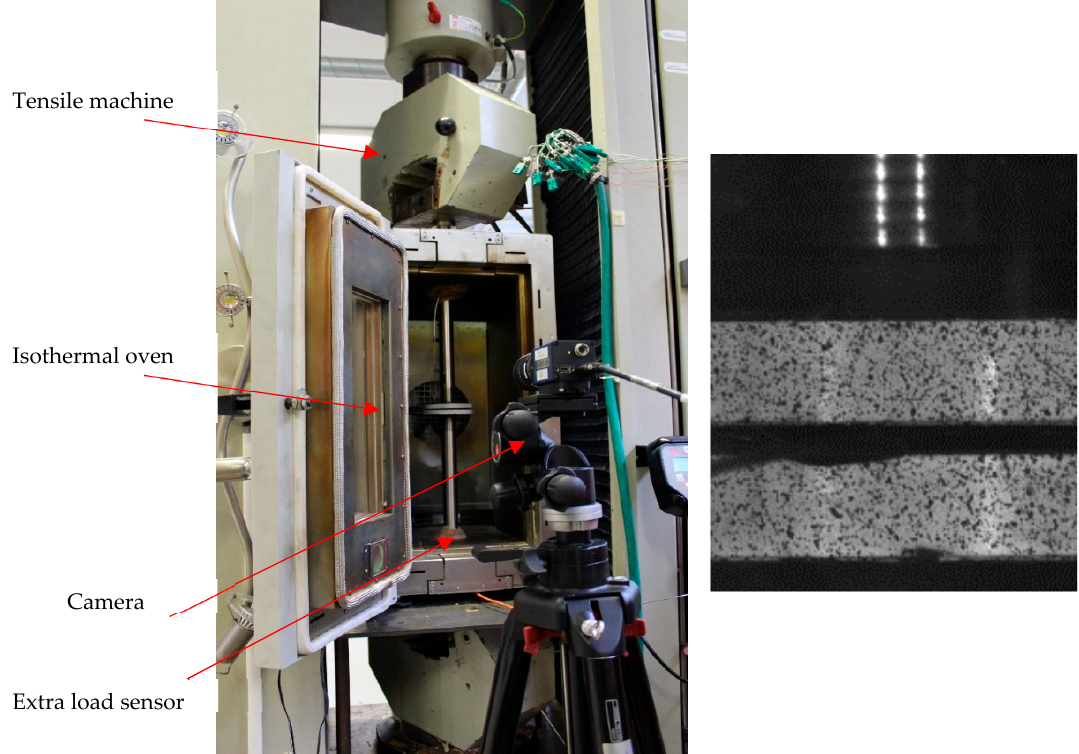
Figure 5. High-temperature compaction test device.